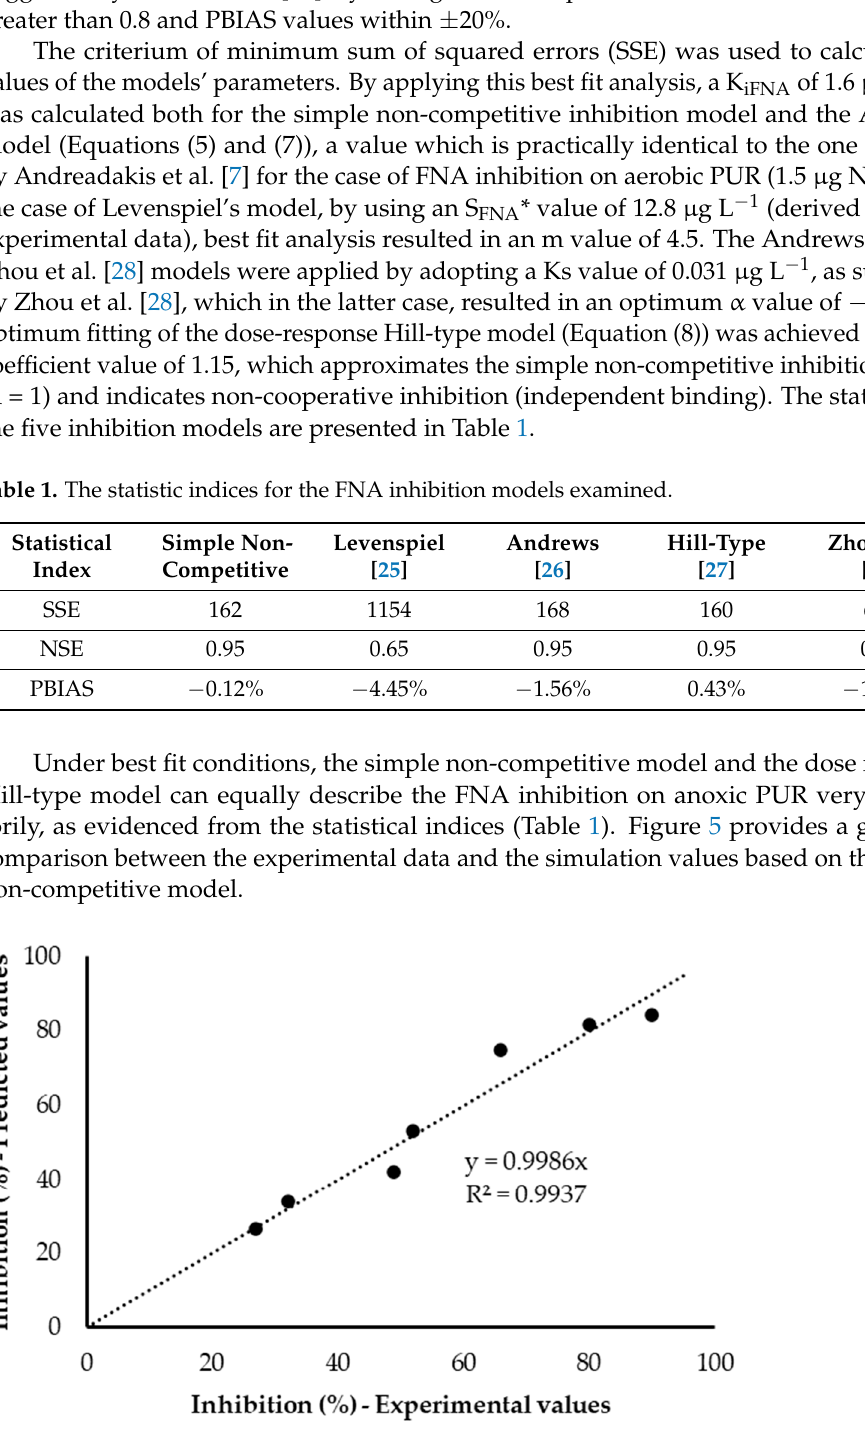
Figure 5. The predicted versus the experimental values for the free nitrous acid inhibitive effect on PAOs anoxic activity (predicted values were calculated based on the simple non-competitive